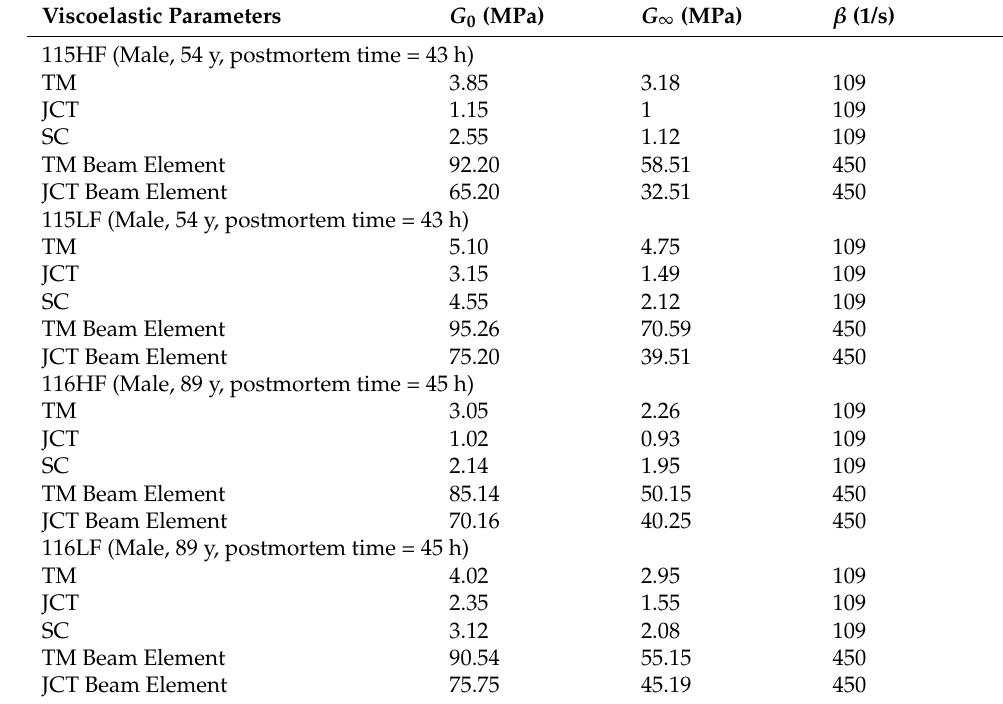
Table 3. Viscoelastic parameters for the TM, JCT, and SC inner wall FE model in healthy eyes. The ECM and beam elements were modeled as the viscoelastic material.